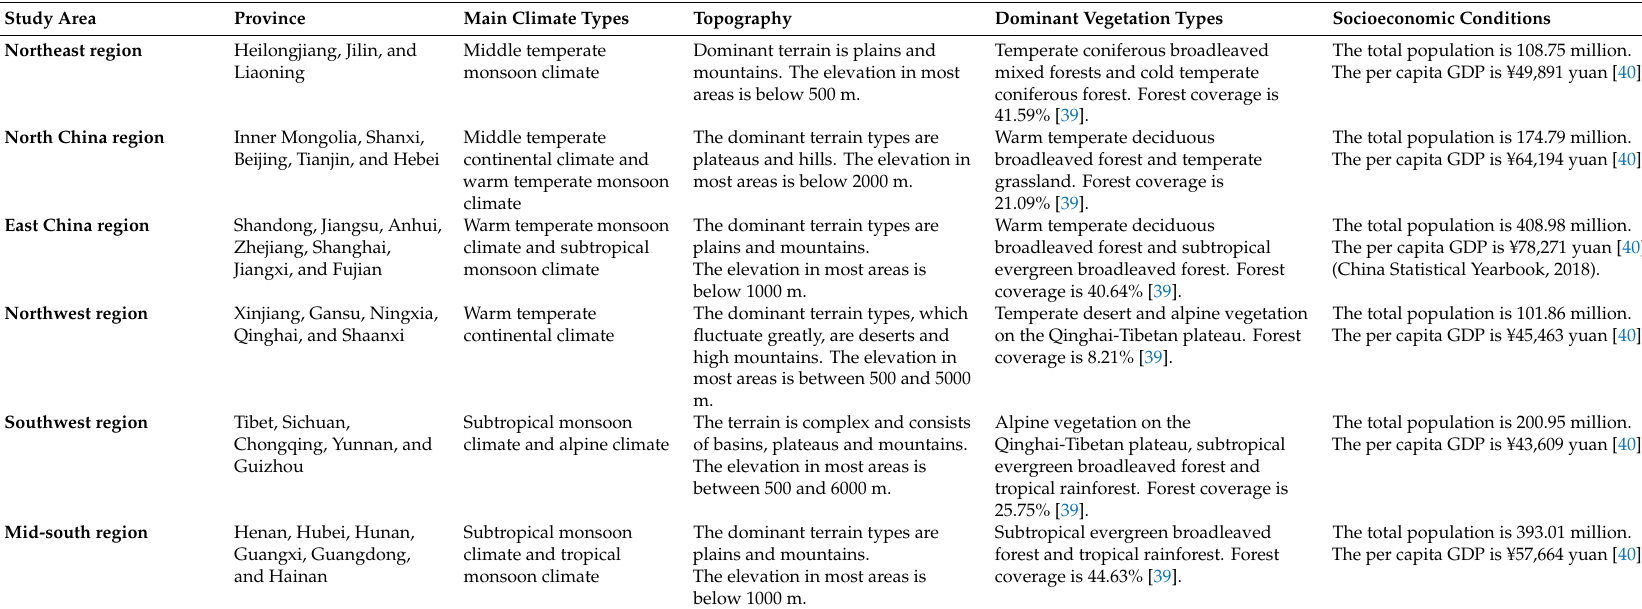
Table 1. Basic description of the six geographical regions in